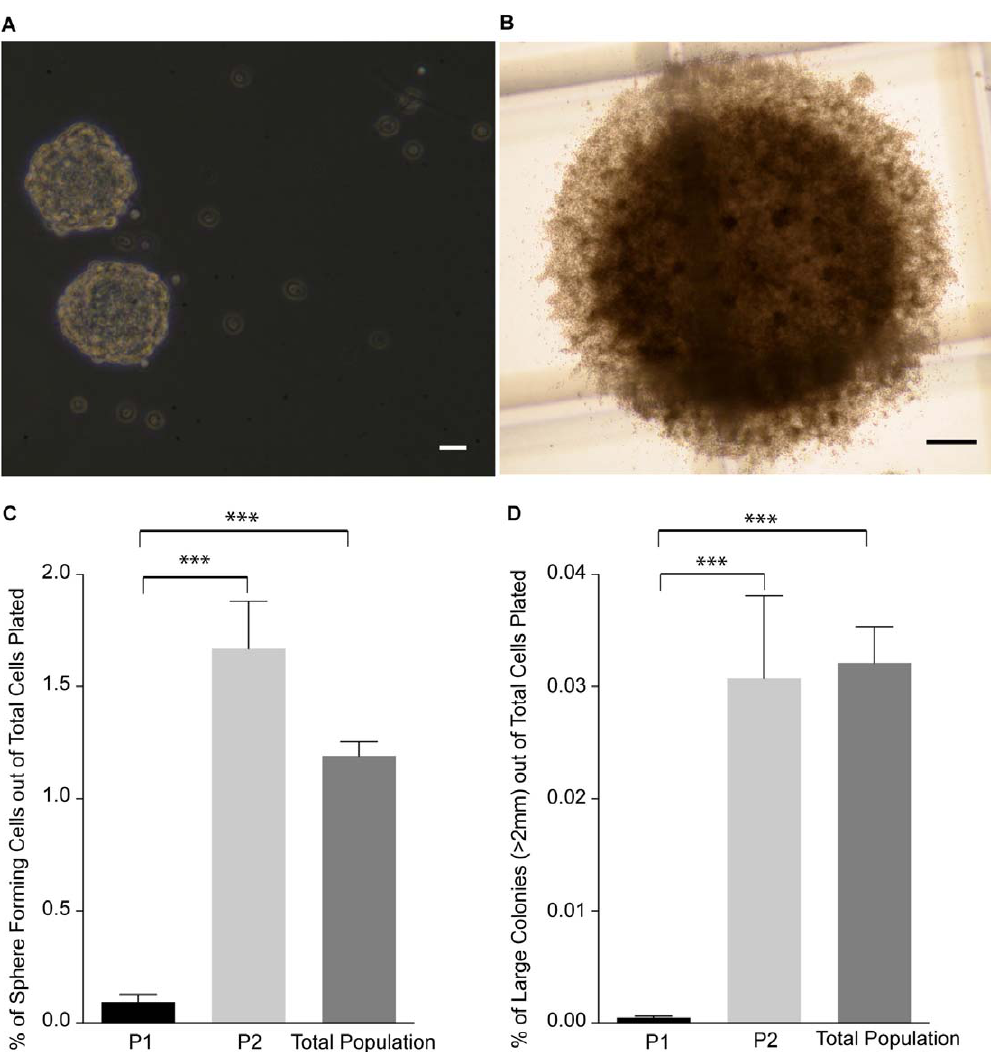
Figure 2. Frequency of stem and progenitor cells in the sorted populations using the NSA and N-CFCA. ( A ): Representative spheres from sorted cells, 7 days after plating in NSA culture. ( B ): Typical large colony ( . 2.0 mm) that is derived from a NSC, 21 days after plating in the N- CFCA. ( C–D ): Comparing the means of the sphere forming frequency in the NSA ( C ) and large colony ( . 2 mm) frequency in the N-CFCA ( D ) of cells sorted from the P1, P2 and P3 population. The majority of neural stem and progenitor cells can be removed from the neuronal cell population (P1), sorting based on FSC and SSC properties. (mean 6 SEM; n=3 2 6 independent experiments; *** p , 0.0001, one way ANOVA). Scale bars=50 m m for A and 250 m m for B . Abbreviations: NSA=Neurosphere assay, N-CFCA=neural- colony forming cell